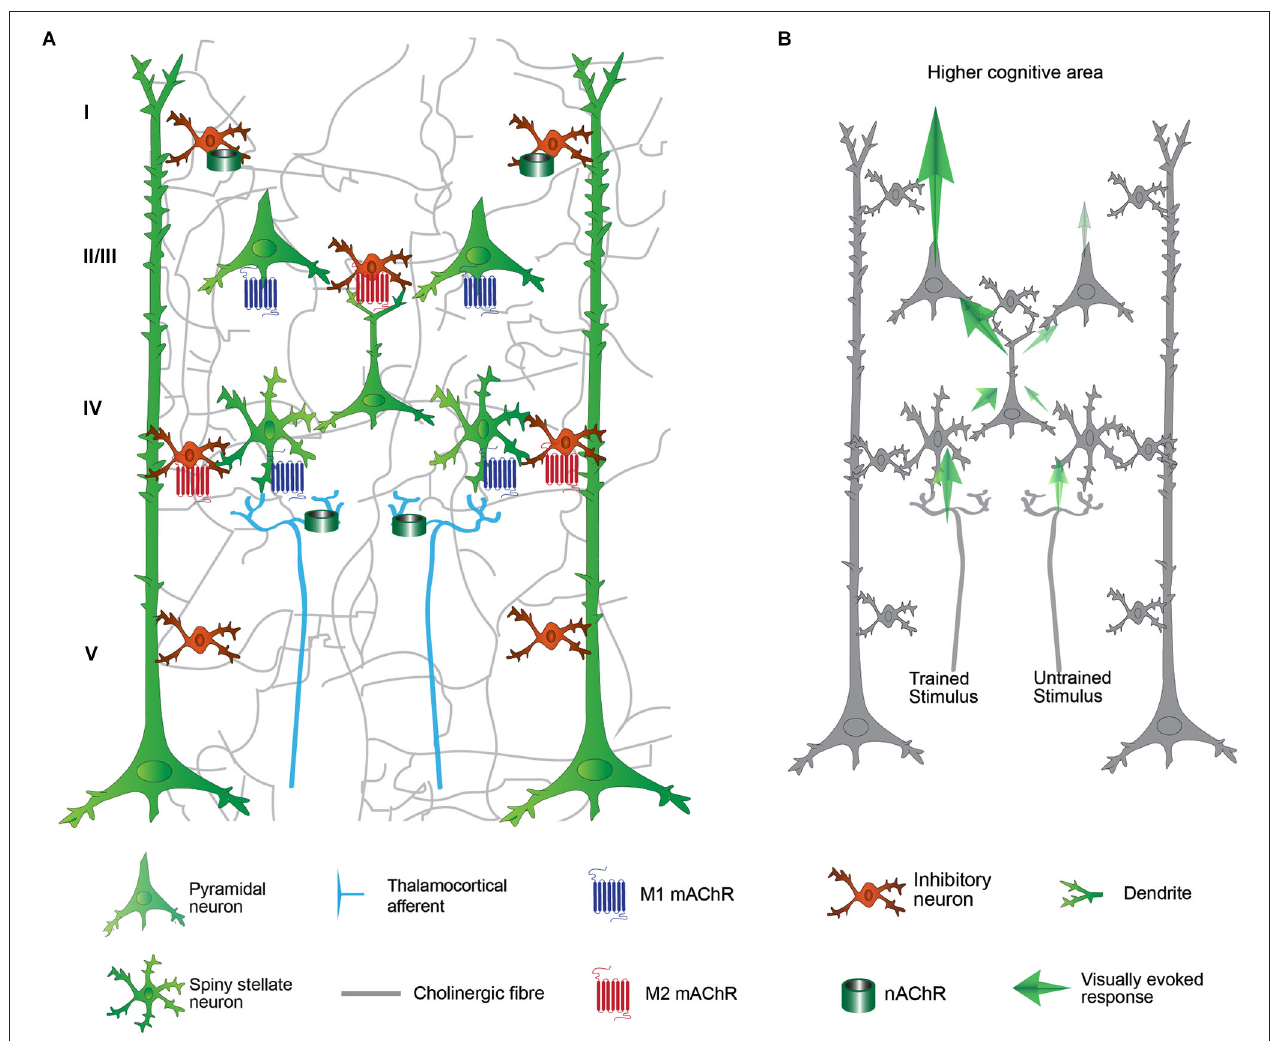
receptors. (B) Cortical processing after VS/HDB training. The cortical processing for the trained stimulus is significantly enhanced after VS/HDB training but un-trained stimulus processing is not affected. Note that the input from the thalamus is similar but the feedforward propagation is increased. Excitatory influences are shown in blue arrows. The strength of the response enhancement is represented by the contrast of the arrow. Layer VI and horizontal connections are omitted for